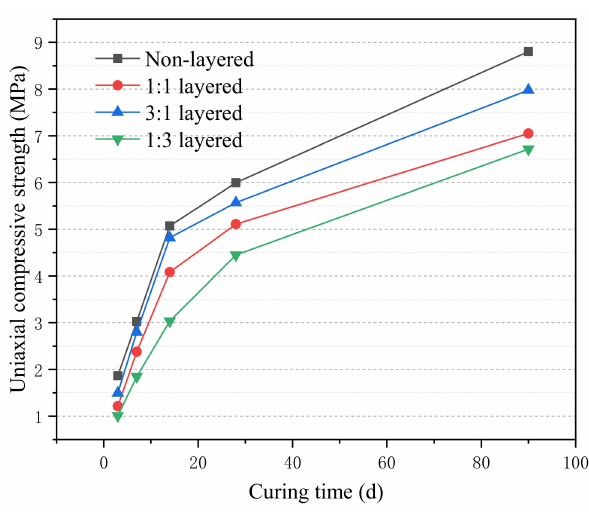
Figure 13. Variation diagram of uniaxial compressive strength under the influence of curing time and different layered